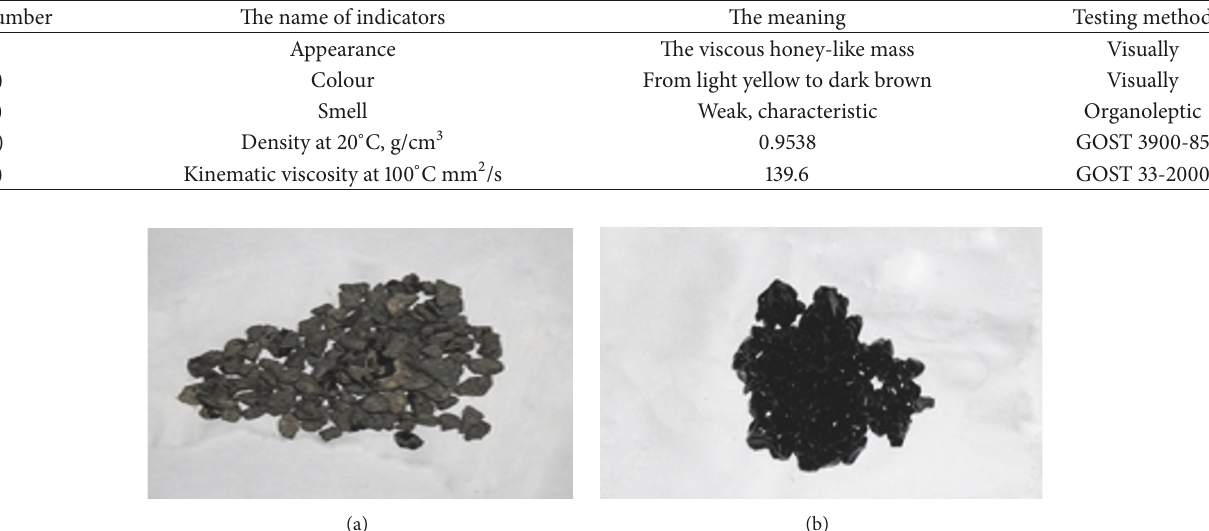
Figure 4: The results of the impact of adhesion additive on the adhesion between bitumen and aggregates: (a) the original bitumen 60/90 without additive; (b) bitumen with 1 wt.% of